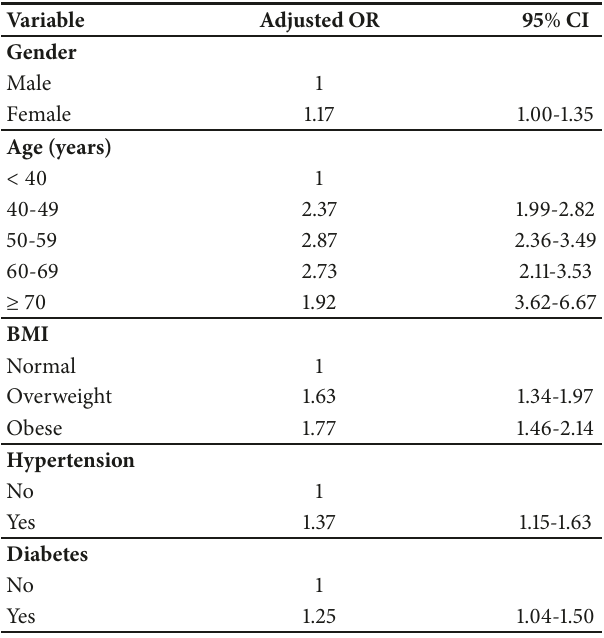
Table 3: Adjusted odds ratios and their 95% Cl for Hypertriglyc- eridemiausing multivariate logistic regression, Jordan,